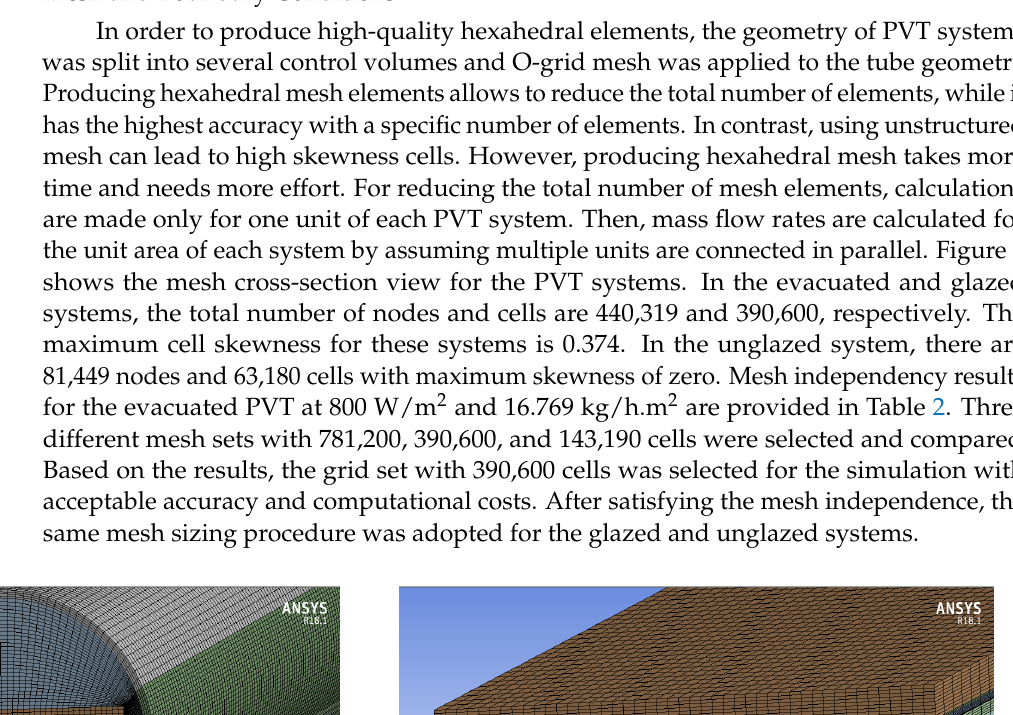
Table 2. Mesh independency check for the evacuated PVT system.